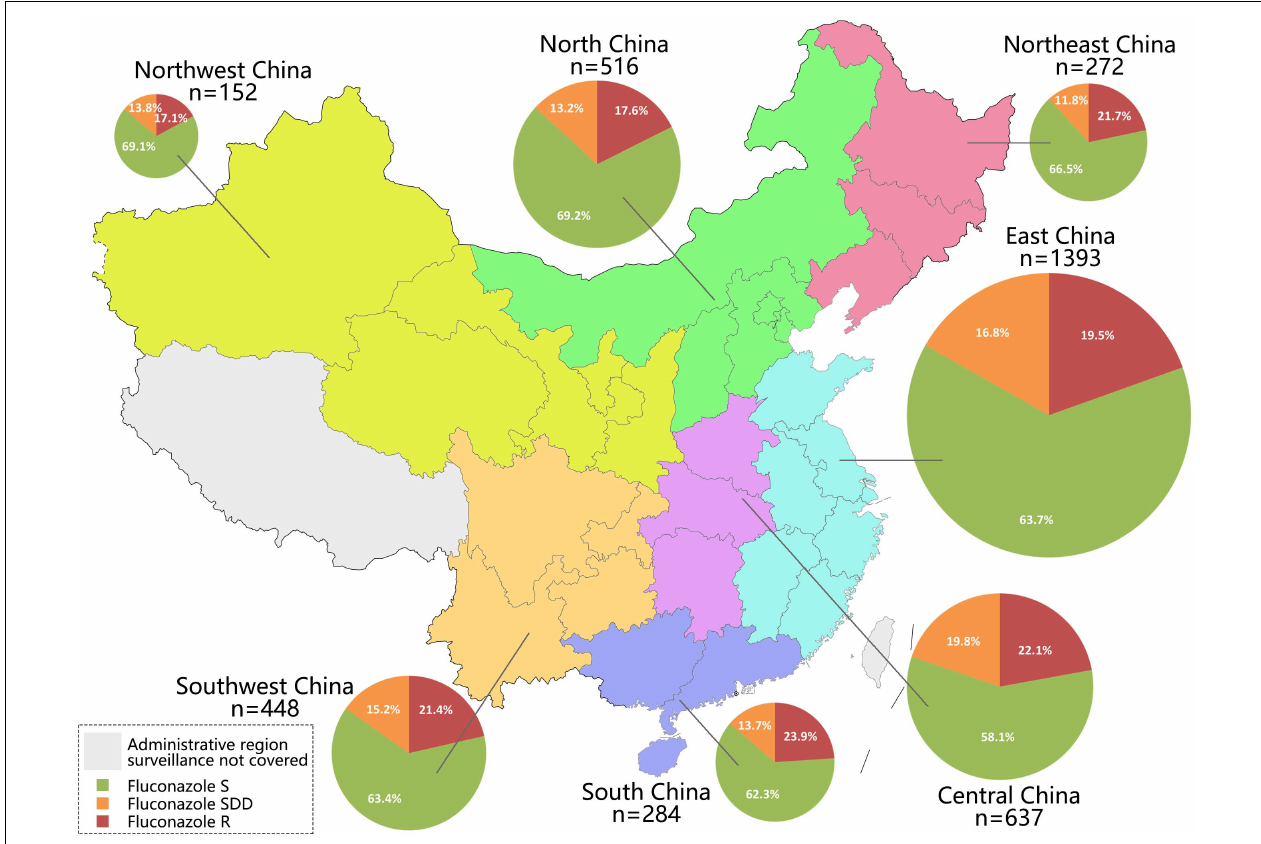
FIGURE 2 | Number of isolates collected in seven administrative regions of China (labeled by different colors), and proportion of fluconazole susceptible (S), susceptible dose-dependent (SDD), and resistant (R) isolates in each